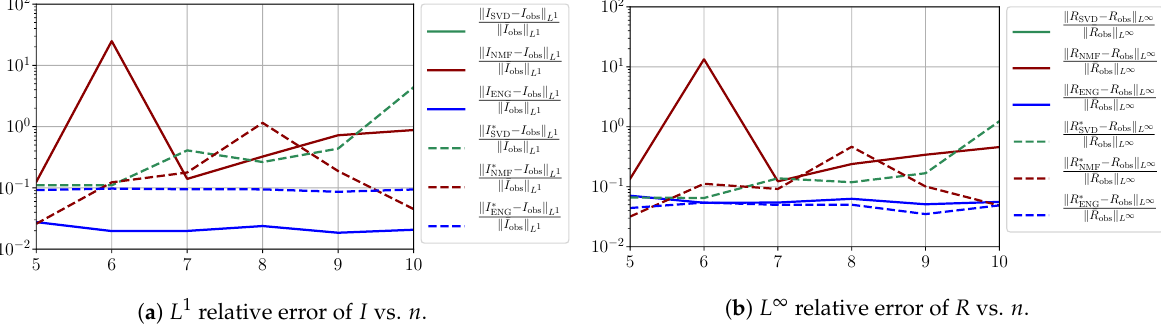
Figure A13. Forecasting errors of I and R (from T = 09/04).